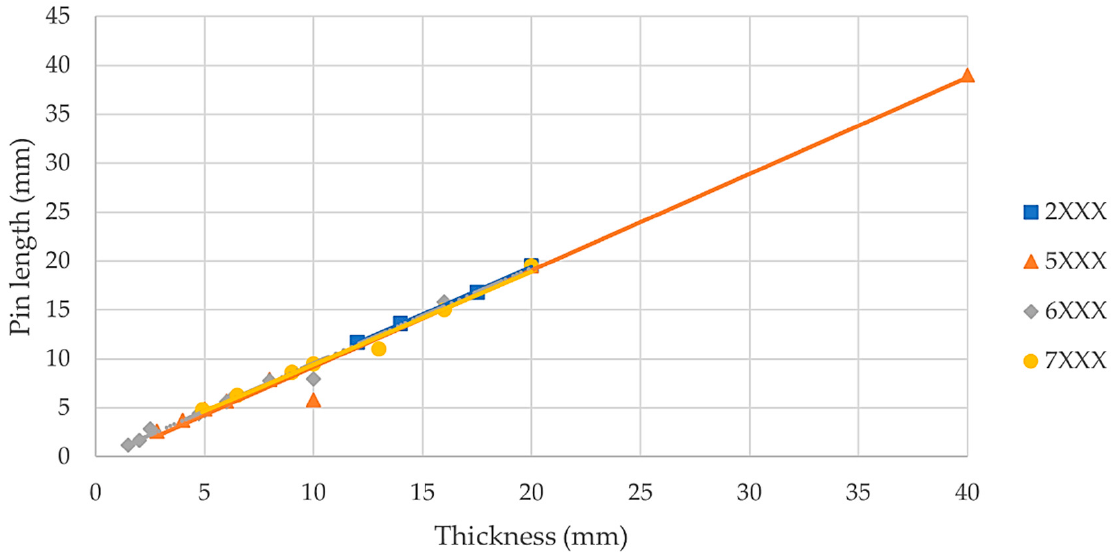
Figure 6. Summary of trend lines for pin length vs. thickness.